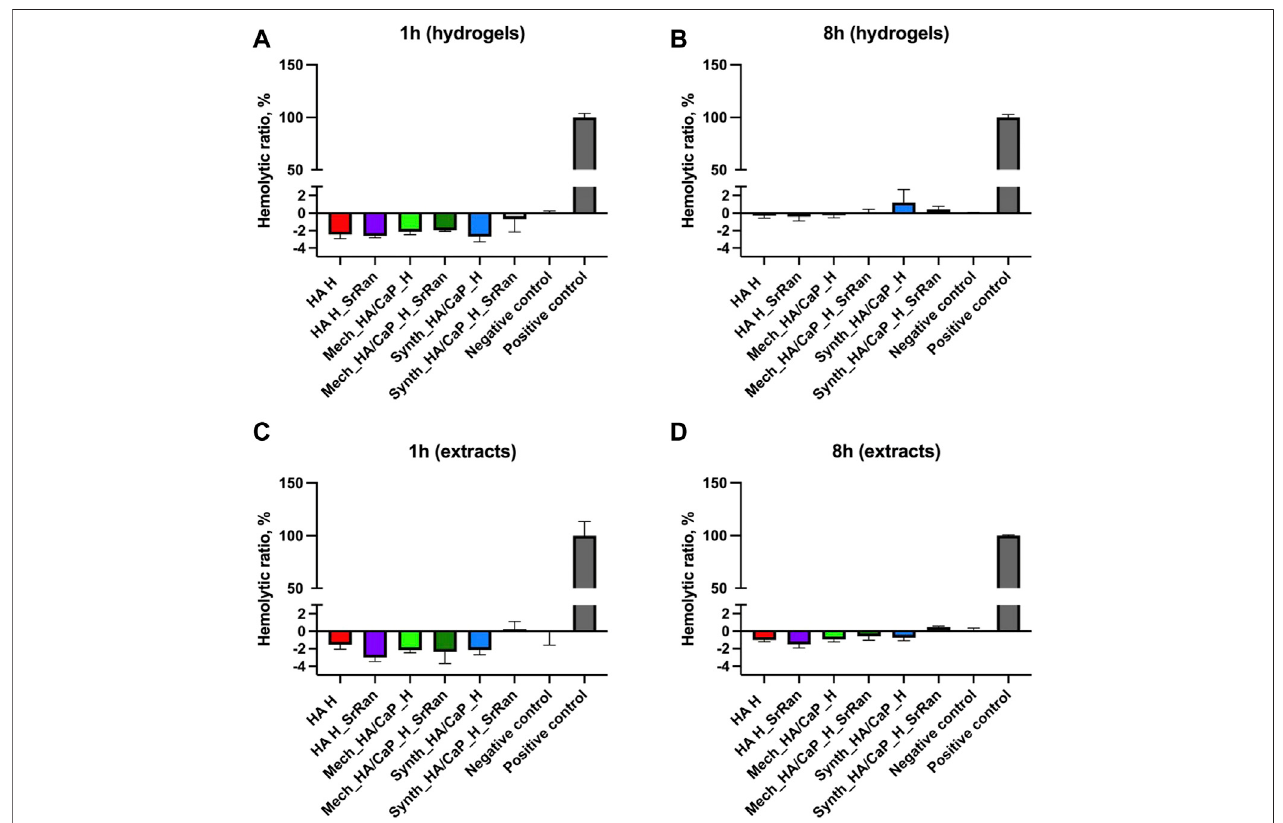
FIGURE 12 | Hemocompatibility of hydrogels (A,B) and hydrogel extracts (C,D) ; positive control: deionized water; negative control: PBS (pH 7.4); n = 3.